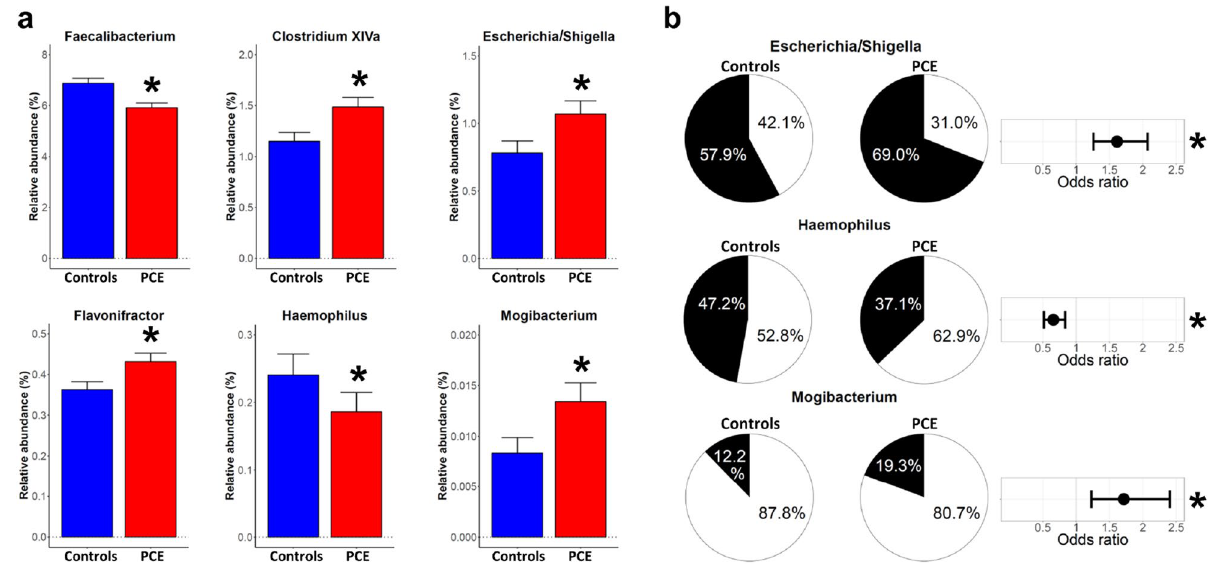
Figure 2. Differences in intestinal microbiota composition between individuals post-cholecystectomy (PCE) and controls without gallstone disease. ( a ) Barplots (mean + sem) depict all taxa at genus level with significantly (*) different abundance between controls (n = 580, blue) and PCE cases (n = 580, red). ( b ) Presence-absence alterations of gut microbiota. Pie charts are displaying the fraction of non-zero samples (in black). Shown are all taxa with significant increase or decrease in PCE compared to controls. The odds ratios represent the reduced or increased likelihood of the respective taxon to be present in PCE samples compared to